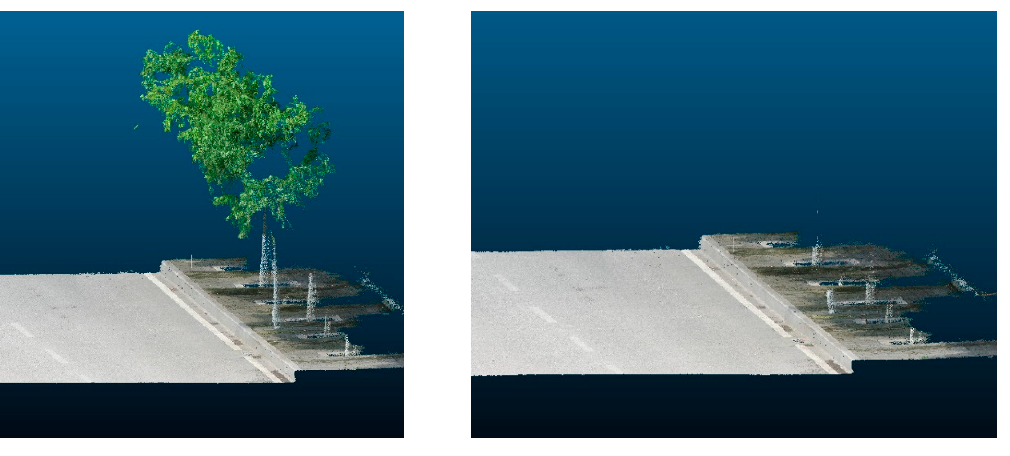
Figure 5. Data filtering of tree leaves